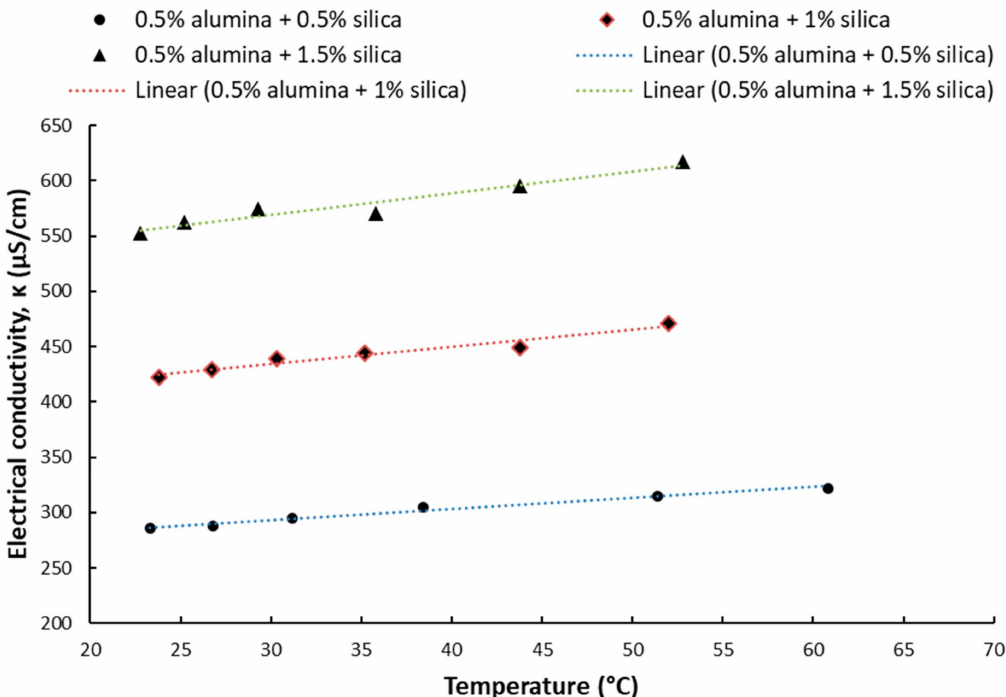
Figure 5. Experimental results on alumina + silica hybrid nanofluid electrical conductivity variation with